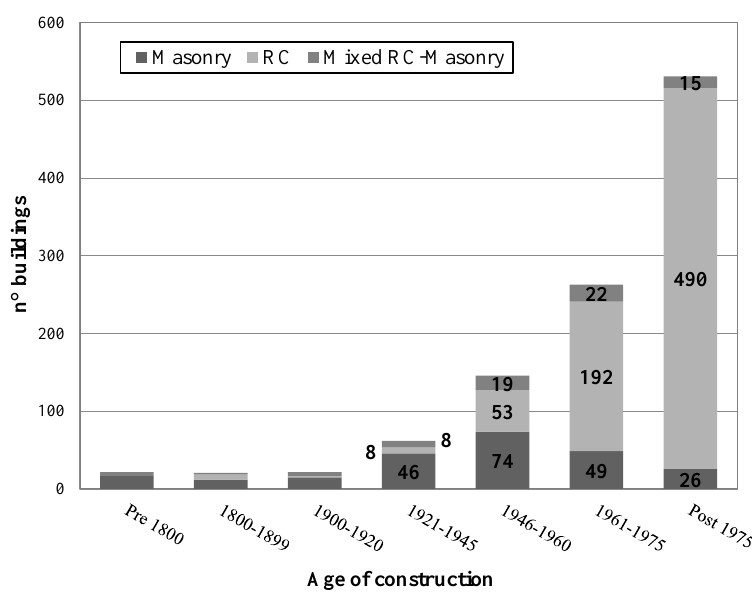
Figure 5. Distribution of construction age for the dataset of 1067 buildings.